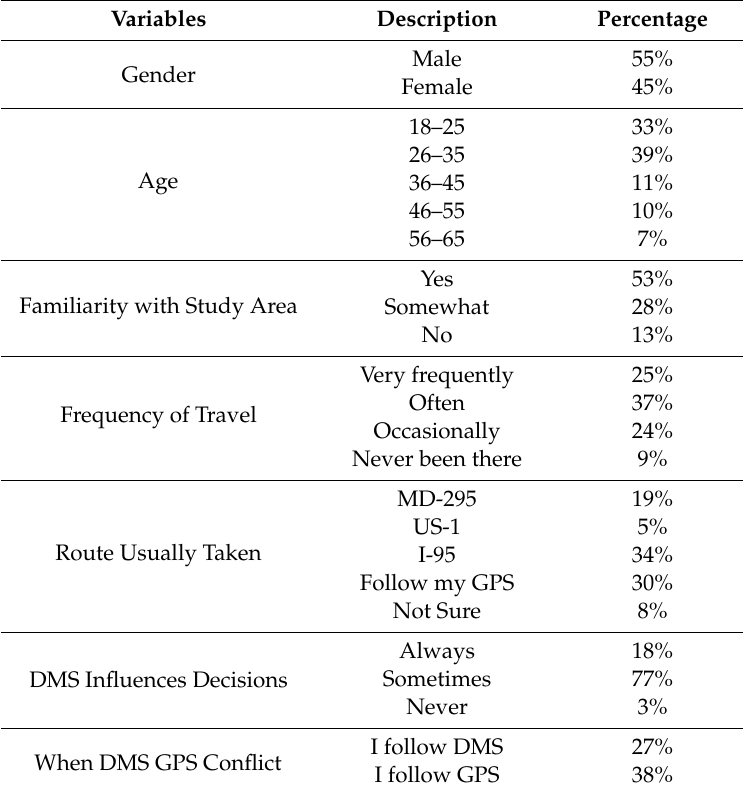
Table 3. Sociodemographic and survey data descriptive